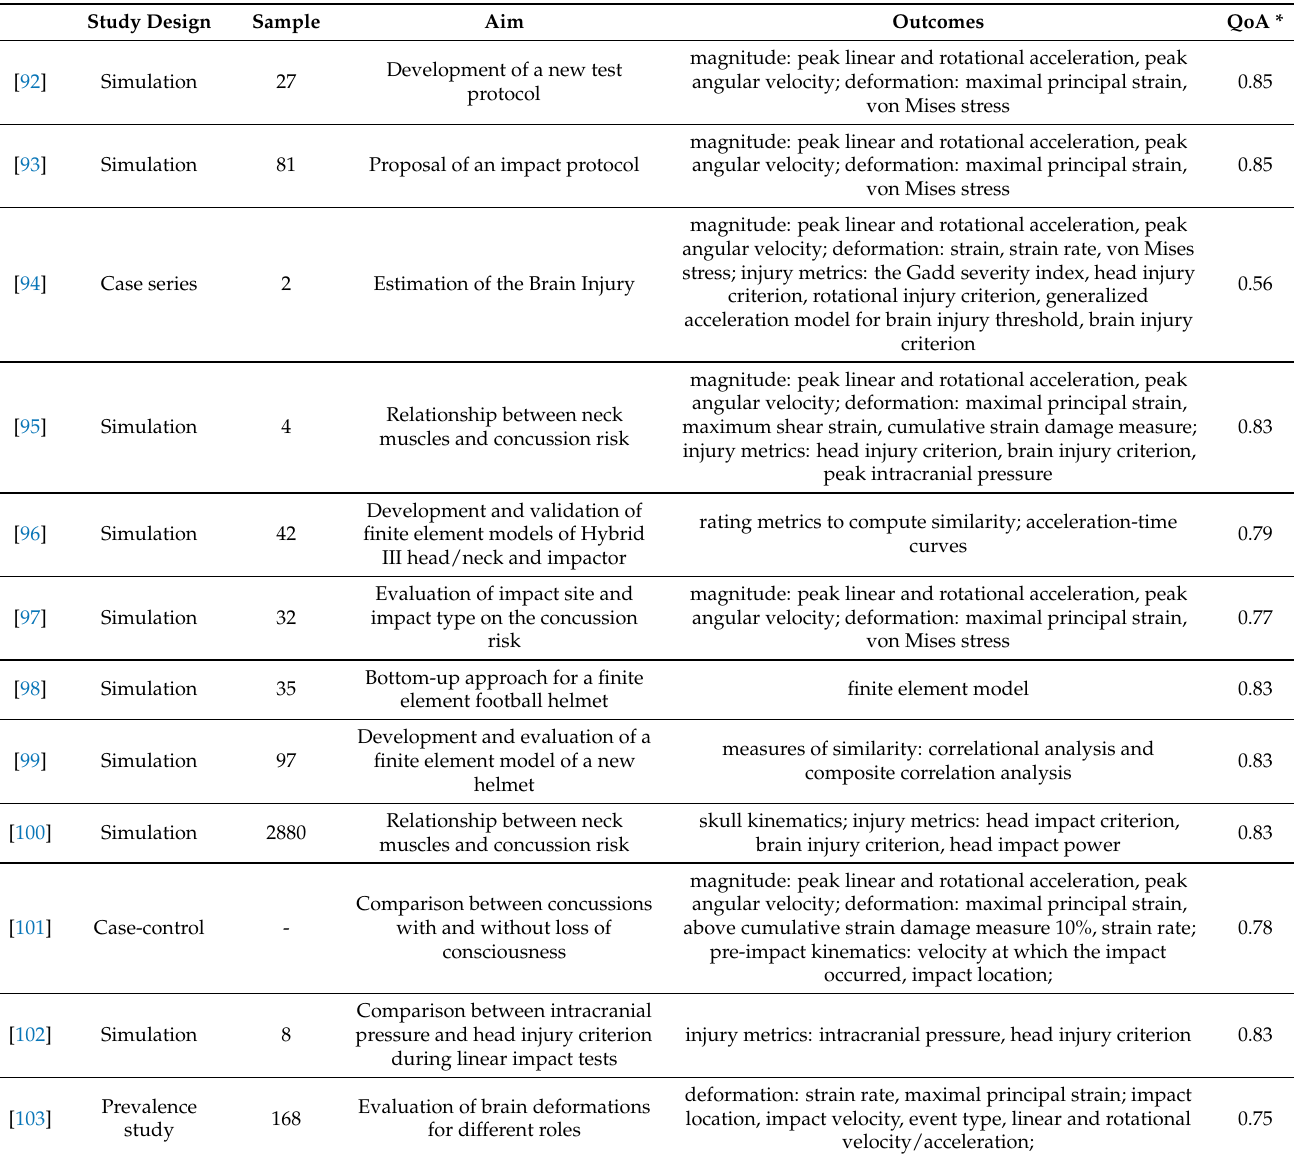
Table 4. Studies regarding the biomechanics of concussion studied by